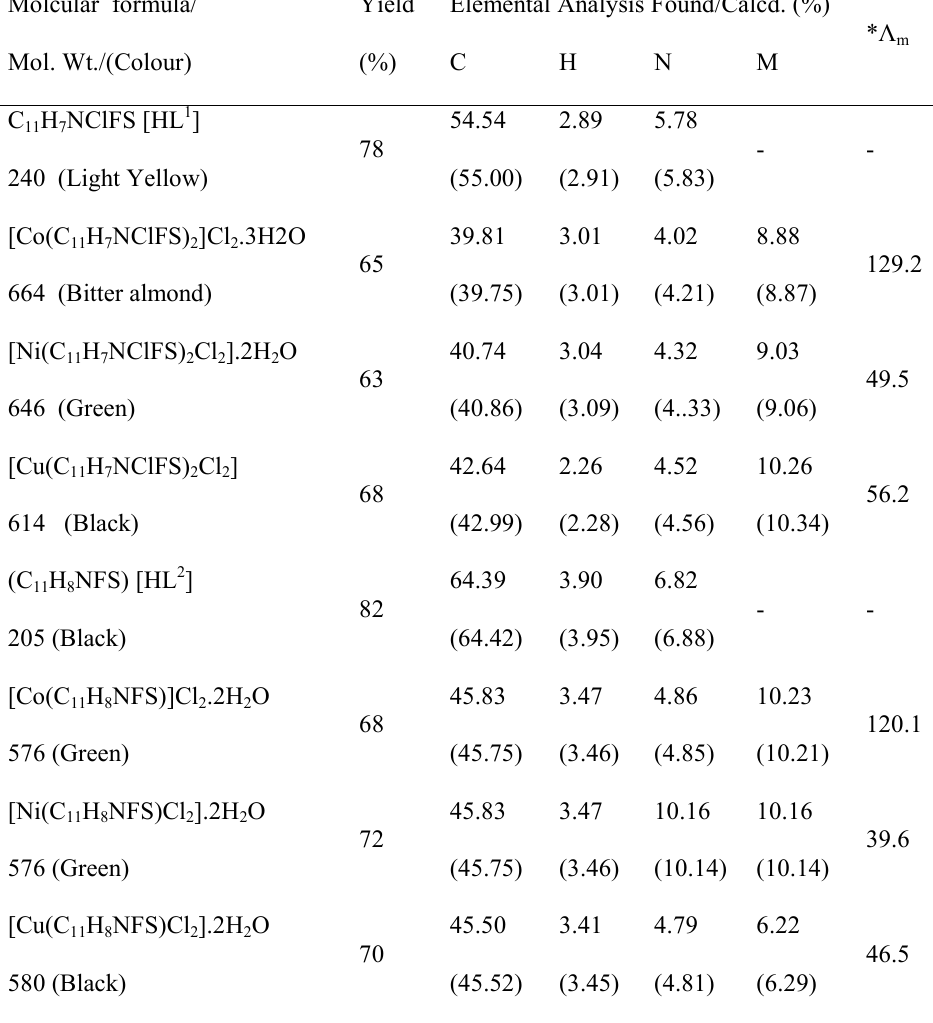
Table 1. Analytical and Physical Data of Ligand and its Metal Complexes. Molcular